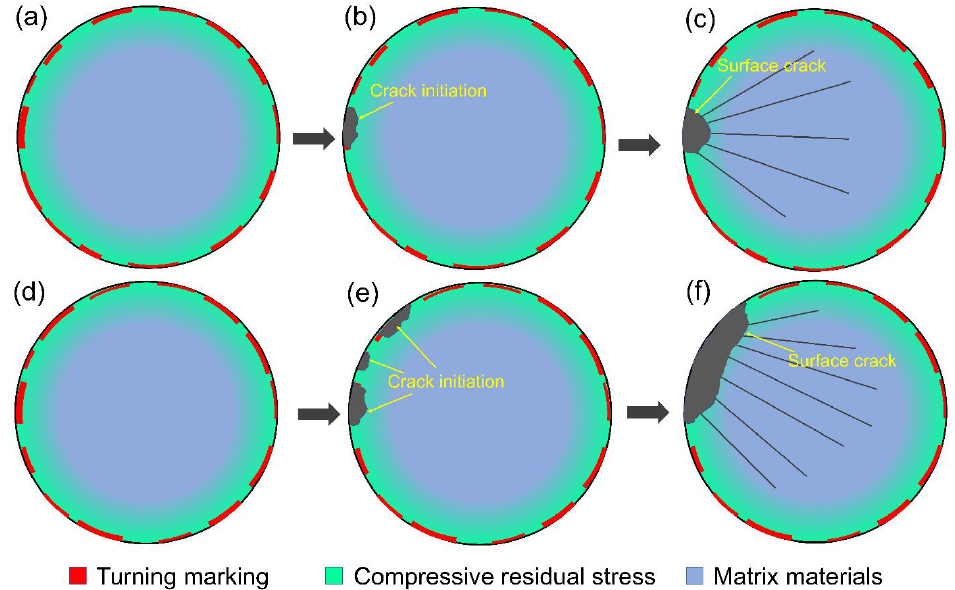
Figure 12. Schematic description of crack initiation and early propagation of turned samples at high applied stress in the HCF regime ( a – c ), and at low applied stress in the VHCF regime ( d – f ): ( a ) and ( d ) surface turning marks and compressive residual stress induced by the turning process, ( b ) crack initiating from a deep surface turning mark at high applied stress, ( c ) surface crack breaking through the compressive residual stress belt and rapid propagation until final fracture, ( e ) several cracks initiating from turning marks and tending to coalesce along the surface direction at low applied stress, ( f ) these cracks slowly propagating and coalescing to an annular notch in the compressive residual stress belt, and then rapidly propagating until final fracture.